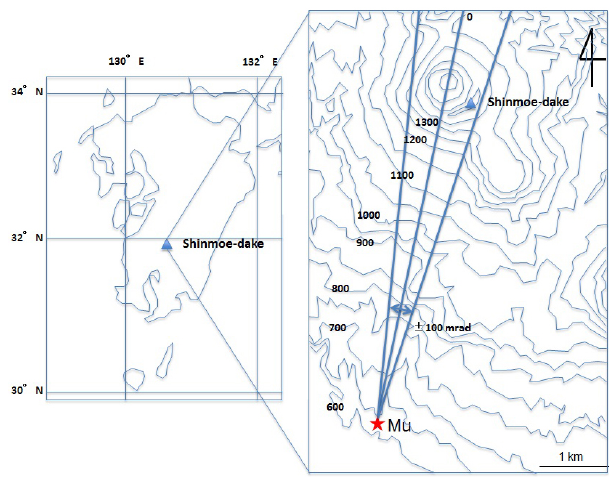
Figure 7. Geometrical configuration of the experimental setup. The left panel shows the location of the Shinmoe-dake volcano. The right panel shows an enlarged map in the vicinity of the Shinmoe- dake volcano. The muography telescope (Mu) was located 5km south–southwest from the center of the Shinmoe-dake volcano caldera. The topographic map does not reflect the land deformation during the 2011 eruption.